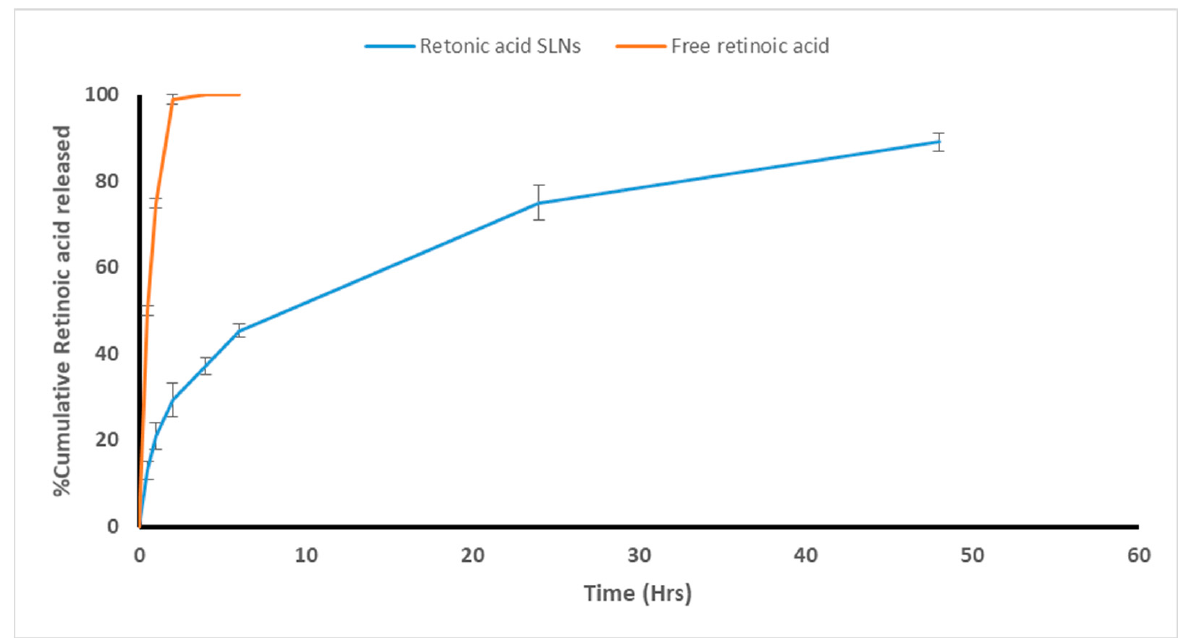
Figure 3. In vitro release profile of